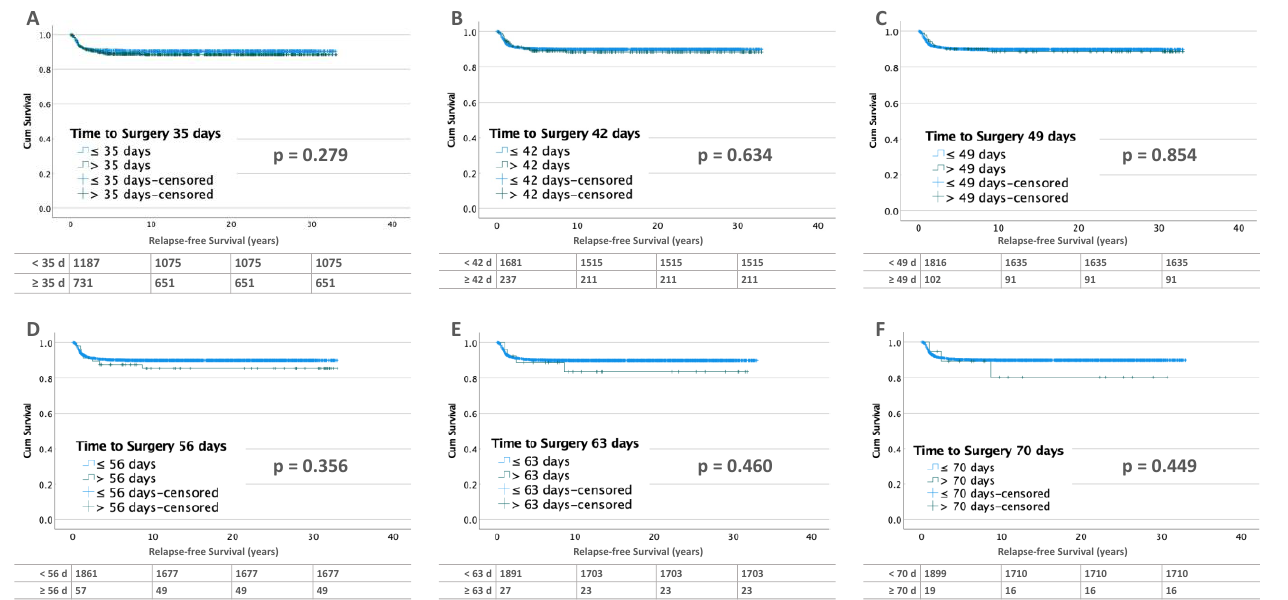
Figure 2. Kaplan – Meier lifetables of RFS of unilateral WT without metastases at diagnosis at thresh- olds of 35 ( A ), 42 ( B ), 49 ( C ), 56 ( D ), 63 ( E ) and 70 ( F ) days of preoperative chemotherapy. In the tables below the figures, the numbers at risk are reported. This is different in patients with metastatic disease ( n = 449) at diagnosis. After 70 days of preoperative chemotherapy, RFS was significantly worse ( p = 0.032). RFS decreased from 75.2% (TTS ≤ 70 days) to 57.7% (Figure 3).